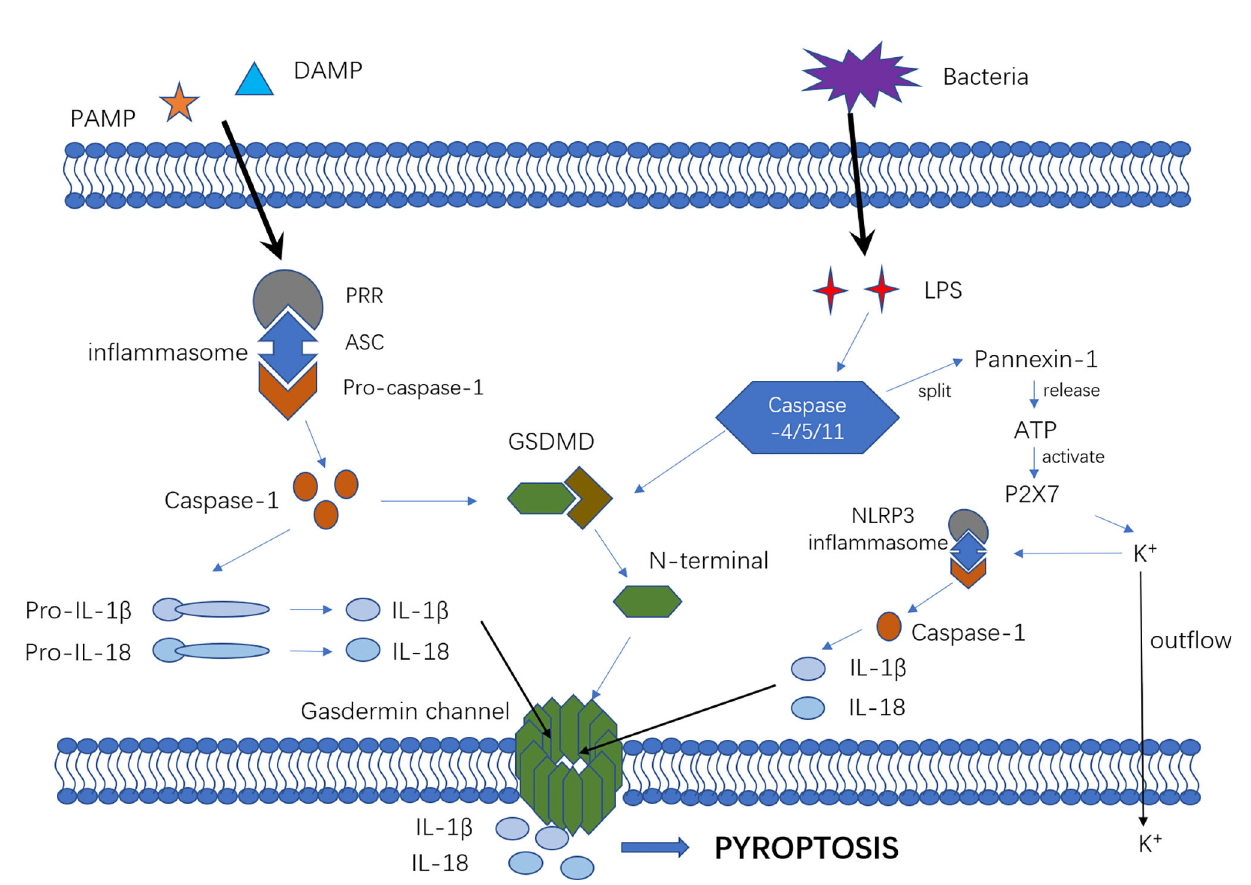
FIGURE 1 | The mechanism of canonical and non-canonical pyroptosis pathway. In the canonical pyroptosis pathway, intracellular pattern recognition receptors (e.g., NLRP1B, NLRP3, NLRC4, etc.) recognize the stimulus signals of pathogens and bind to pro-caspase-1 through the adaptor protein ASC to form a multi- protein complex that can activate caspase-1 protein. In the non-canonical pyroptosis pathway, intracellular LPS directly binds and activates caspase-11/4/5 protein to initiate pyroptosis. After in fl ammatory caspase activation, pro-IL-1 b and pro-IL-18 are cleaved to active IL-1 b and IL-18. The portion of GSDMD that connects the N- and C-terminals is rapidly cleaved to remove the inhibitory effect of the C-terminal on the N-terminal. Then, the N-terminal of GSDMD connects with phosphatidylinositol(PI) on the cell membrane, resulting in an oligomerization effect and formation of the “ gasdermin channel ” . Ion movement through this channel destroys the osmotic balance, leading to cell swelling, membrane dissolution, cell content release, and in fl ammatory response. Furthermore, cytosolic LPS stimulation induced caspase-11-dependent cleavage of the pannexin-1 channel followed by ATP release, which in turn activated the P2X7 receptor to cause ATP-induced loss of intracellular K+, NLRP3 in fl ammasome activation and IL-1b